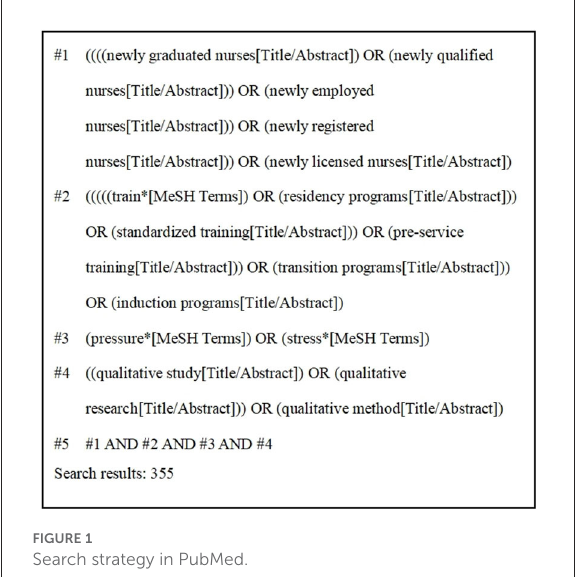
FIGURE1 Search strategy in